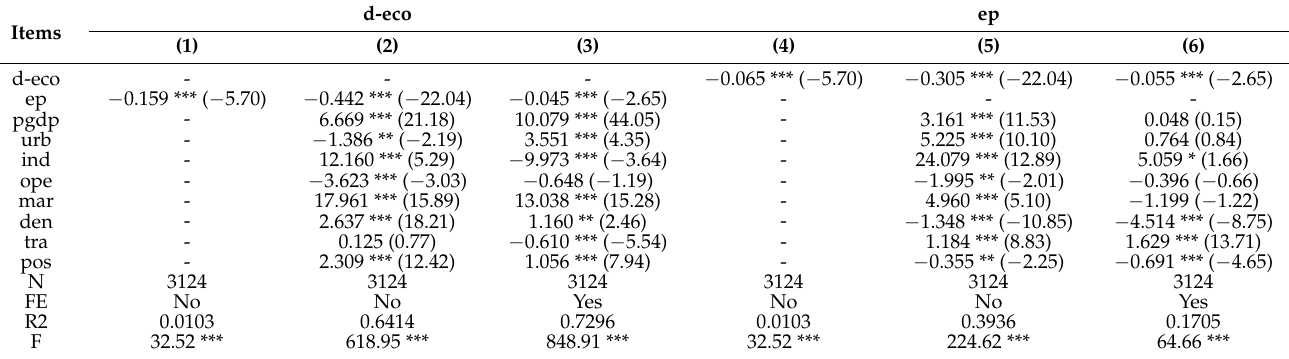
Table 3. Benchmark regression